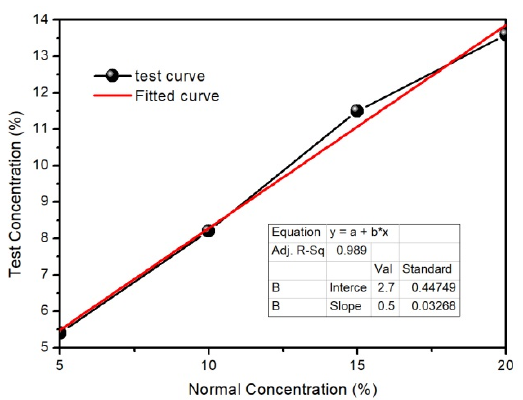
Figure 6. Linearity curve of spectroscopic high throughput blood culture apparatus.